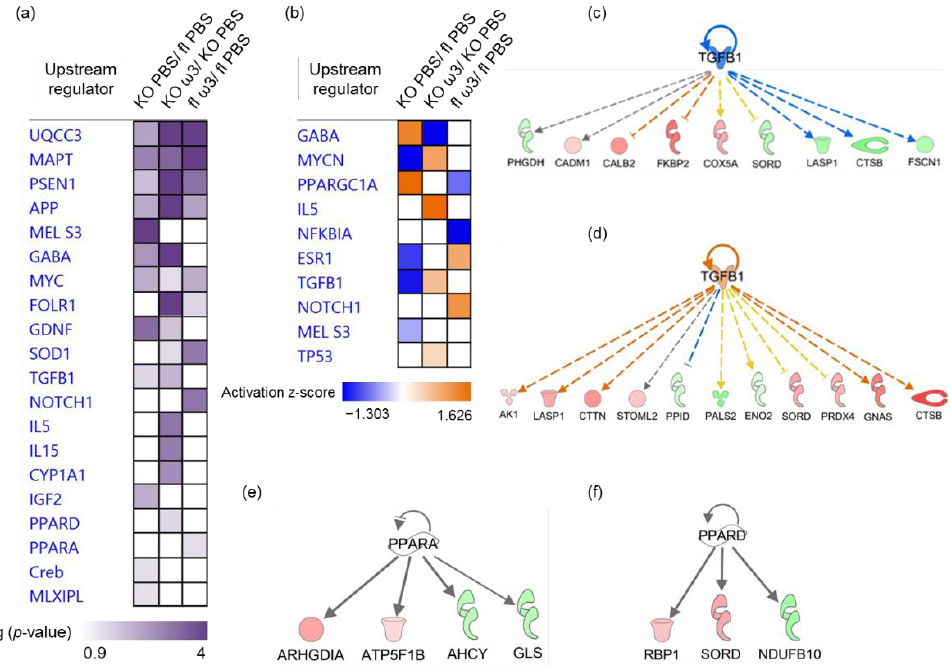
Figure 8. Predicted upstream regulators in the retina. The profiles of top selected predicted upstream regulators according to ( a ) −log10 ( p- value), p < 0.05 and ( b ) activation z-score. Exemplary profiles of significantly affected predicted upstream regulators for the various clusters of differentially expressed proteins represented by interaction networks of ( c ) inhibited TGF- β 1 in the KO group, ( d ) activated TGF- β 1 regulation in ω -3 PUFA-fed KO mice, ( e ) significant regulation by PPAR α and ( f ) PPAR δ . Red and green colours of the proteins represented by functionality nodes indicate up- and down-regulation of the differentially expressed proteins, respectively. The predicted activity of the regulators is shown as orange (activated) and blue (inhibited), and grey indicates an indeterminable activity pattern.